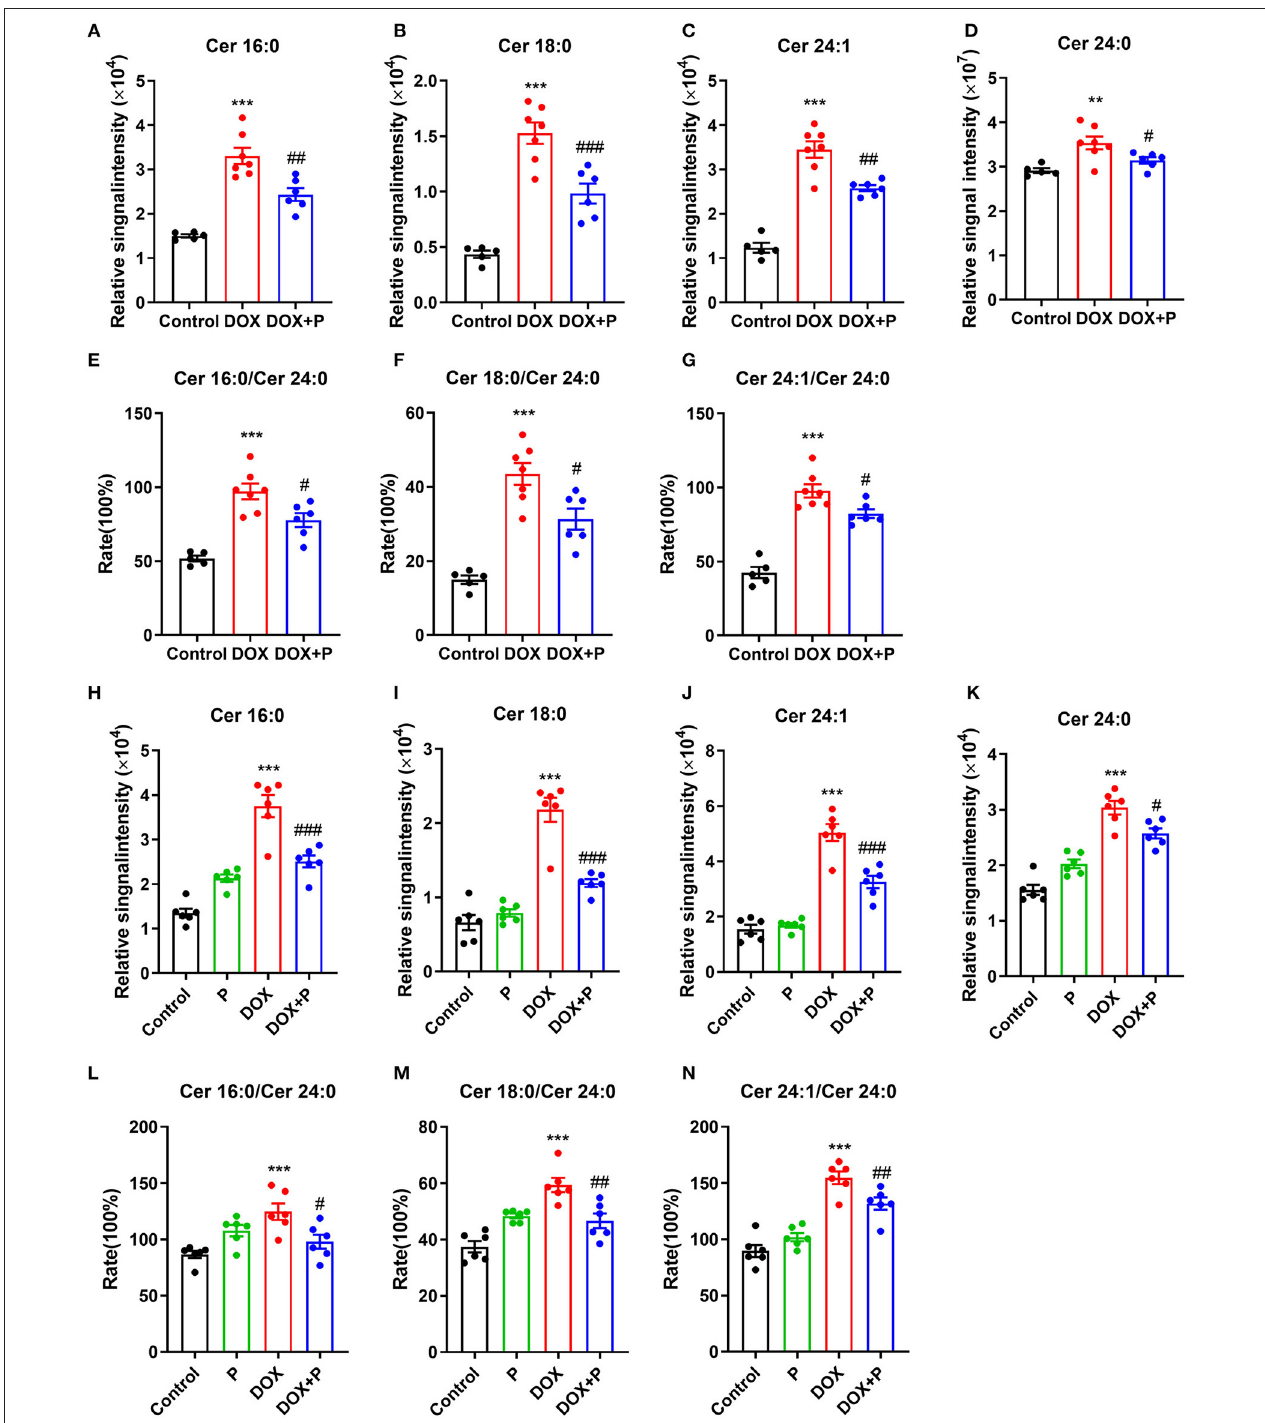
FIGURE 4 | Periplocymarin regulated ceramides metabolism disorder induced by DOX. (A–D) Relative abundance of Cer16:0 (A) , Cer18:0 (B) , Cer24:1 (C) , and Cer24:0 (D) ceramides in mice serum. (E–G) The ratios of Cer16:0 to Cer24:0 (E) , Cer18:0 to Cer24:0 (F) , and Cer24:1 to Cer24:0 (G) in mice serum. Data are presented as mean ± SEM; n = 6, ** p < 0.01, *** p < 0.001 vs. control; # p < 0.05, ## p < 0.01, ### p < 0.001 vs. DOX. (H–K) Relative abundance of Cer16:0 (H) , Cer18:0 (I) , Cer24:1 (J) , and Cer24:0 (K) ceramides in H9c2 cells. (L–N) The ratios of Cer16:0 to Cer24:0 (L) , Cer18:0 to Cer24:0 (M) and Cer24:1 to Cer24:0 (N) in H9c2 cells. Data are presented as mean ± SEM; n = 6, *** p < 0.001 vs. control; # p < 0.05, ## p < 0.01, ### p < 0.001 vs. DOX.